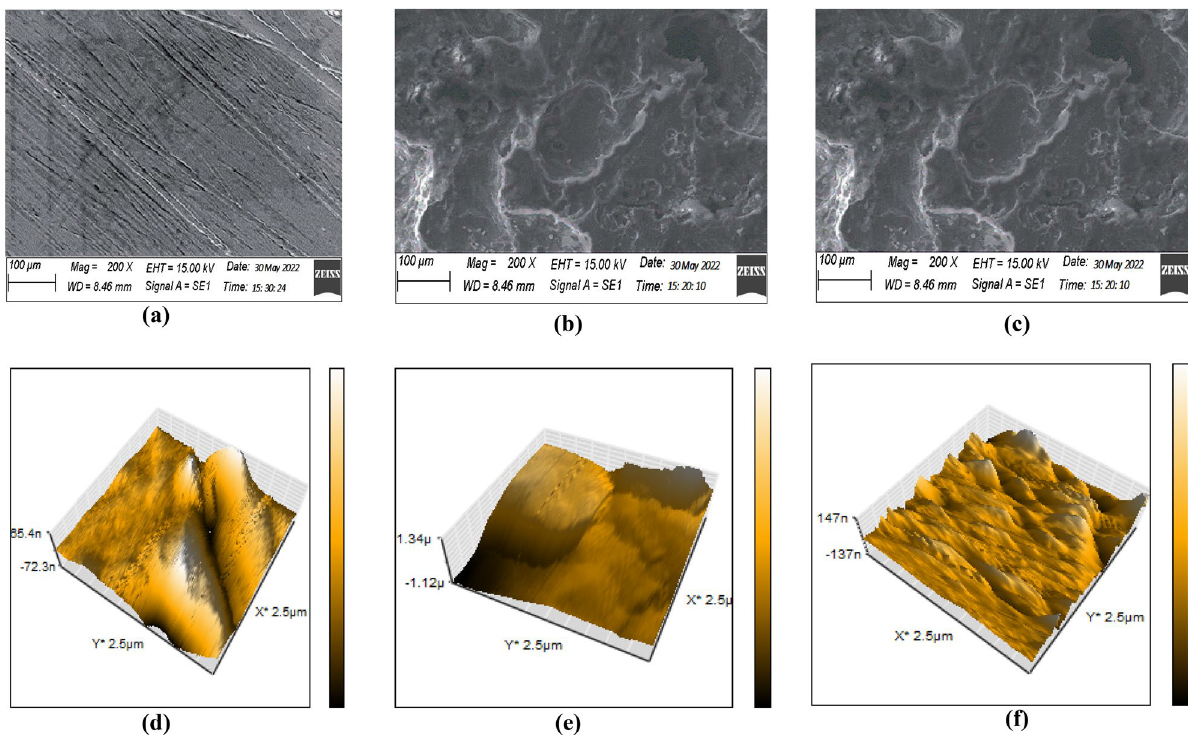
Figure 10. SEM (top row) and AFM images (bottom row) of the ( a ), ( d ) free Cu surface; surface in ( b ), ( e ) 0.5 M HCl and ( c ), ( f ) 0.5 M HCl with DTG